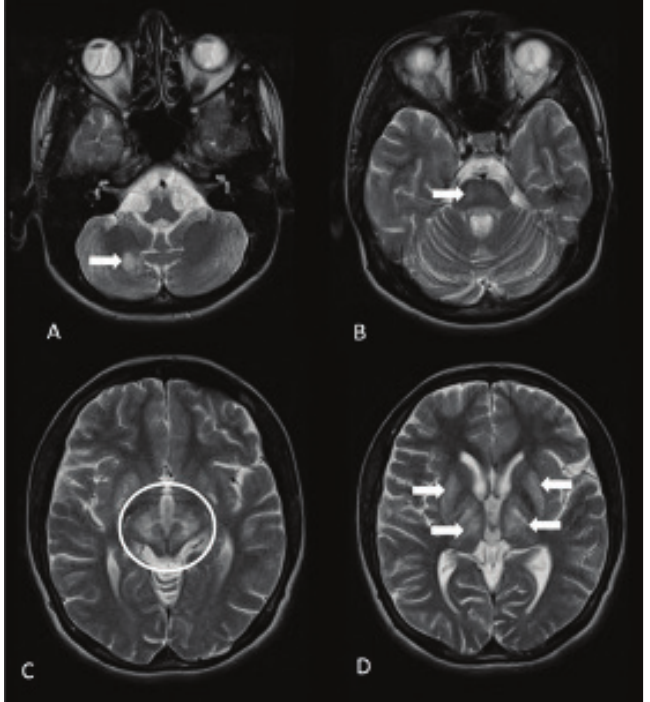
Figure 4 - Case 1: 37-year-old, Female patient, signal loss secondary to accumulation of paramagnetic substance in the globus pallidus and right substantia nigra on gradient echo in A and B, respectively in the patient was being followed with a diagnosis of PKAN. In C, axial T2 images show hypointense signal change in both globus pallidus and accompanying central longitudinal high signal line (eye of the tiger